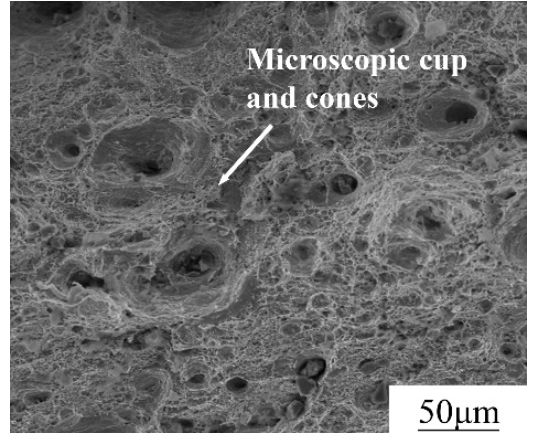
Figure 6. SEM images of the fracture surfaces.